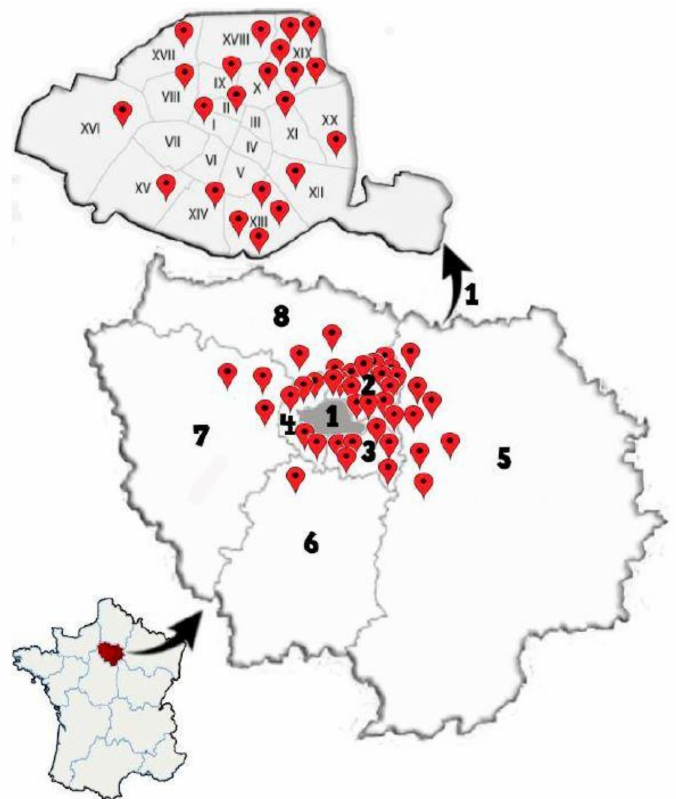
Figure 1. Geographical topology of the processed locations for bed bug sampling in Ile-de-France, France. 1. Paris arrondissements, 2: Seine-Saint-Denis, 3: Val-de-Marne, 4: Hauts-de-Seine, 5: Seine- et-Marne, 6: Essonne, 7: Yvelines, and 8: Val-d’Oise. The arrondissements of Paris are demonstrated by I to XX